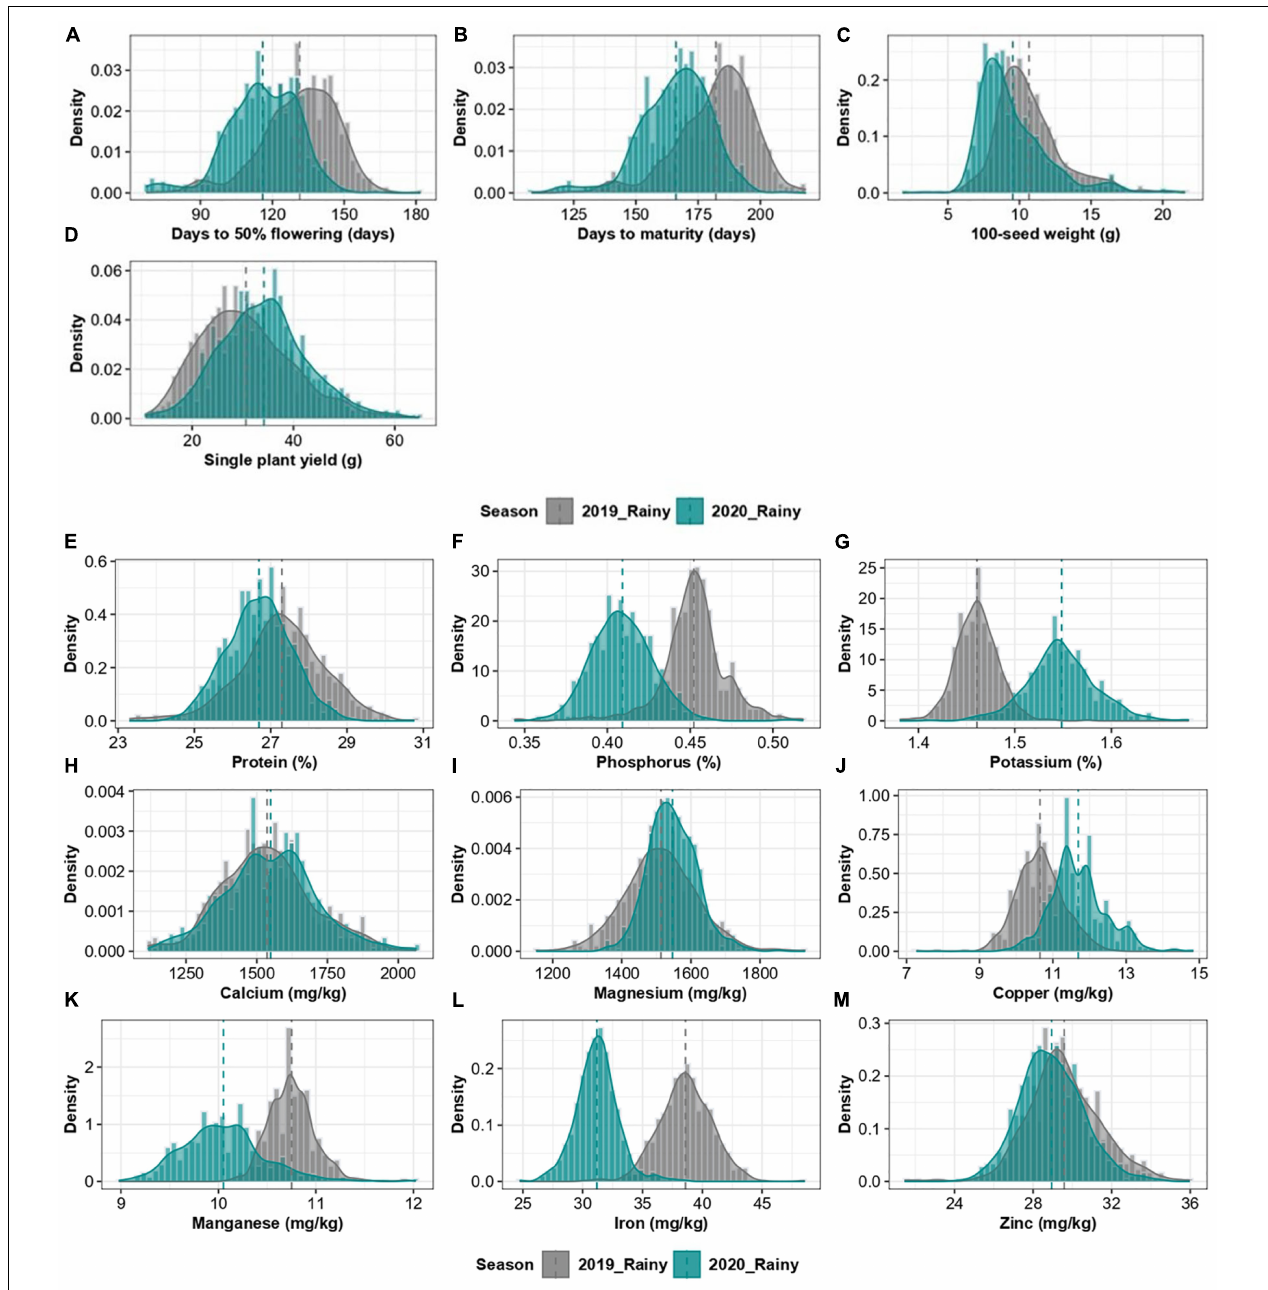
FIGURE 2 | Combined histogram and a density graph, depicting the density of agronomic traits (A–D) and grain nutrients (E–M) of 2019 and 2020 rainy season crops.